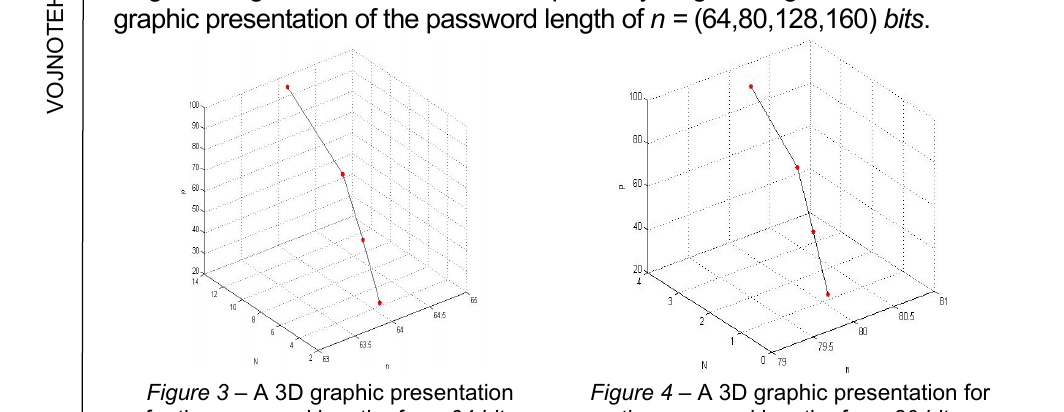
Figure 3 – A 3D graphic presentation for the password length of n = 64 bits Рис . 3 – 3 Д графическое изображение